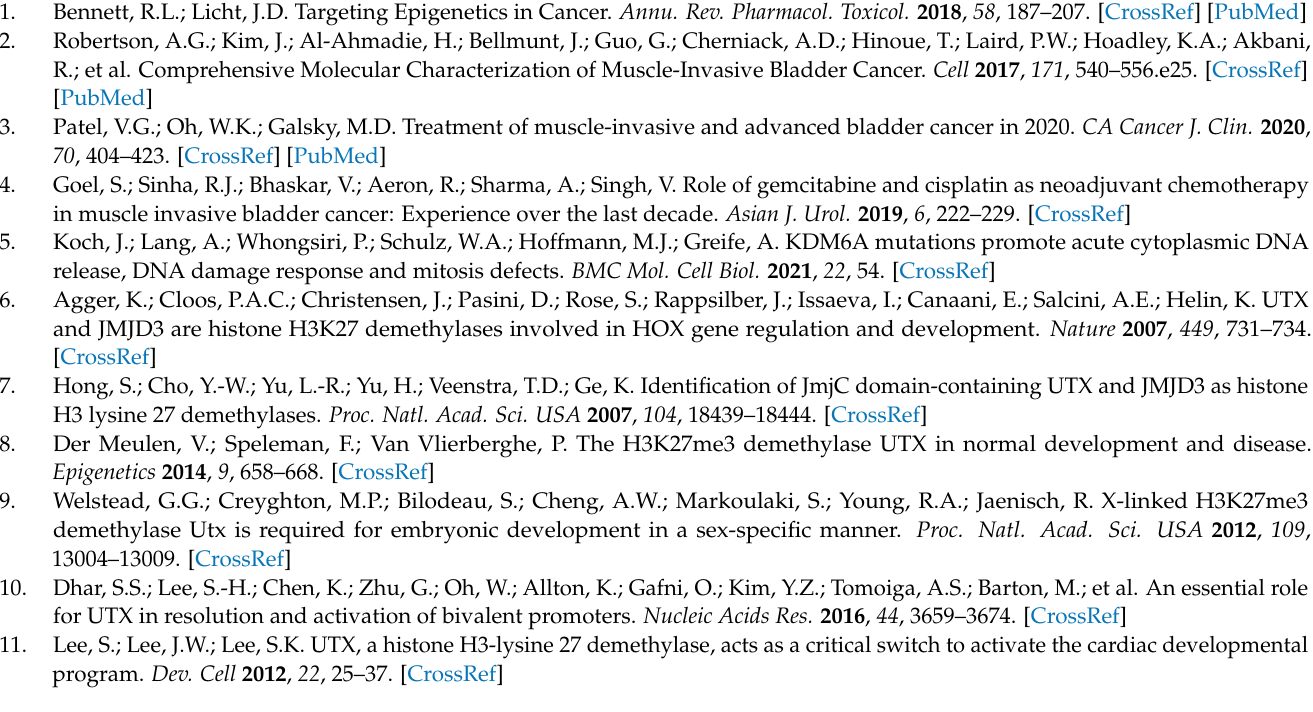
TLE1 -Q:HHEX complex. Figure S10: Original Western Blot images. Table S1: Results of gene ontology analysis performed for the clusters in Figure 1D. Table S2: Genes associated with all T24